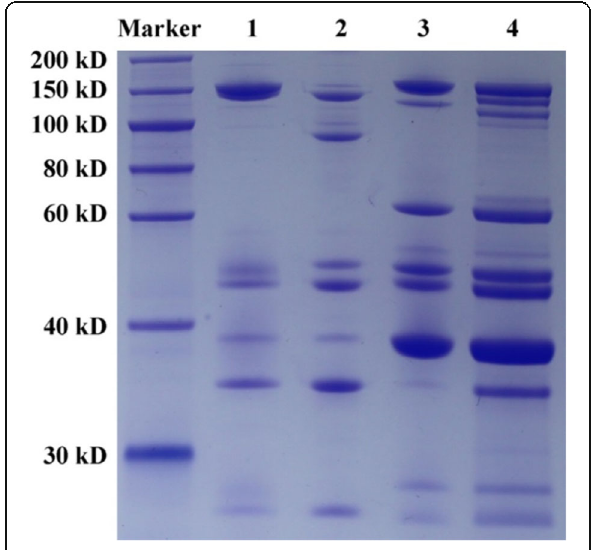
Fig. 2 The SDS – PAGE analysis of the purified BoNT/A and BoNT/B complex. ( Lane 1 : BoNT/A; Lane 2 : DTT-treated BoNT/A; Lane 3 : BoNT/B; Lane 4 : DTT-treated